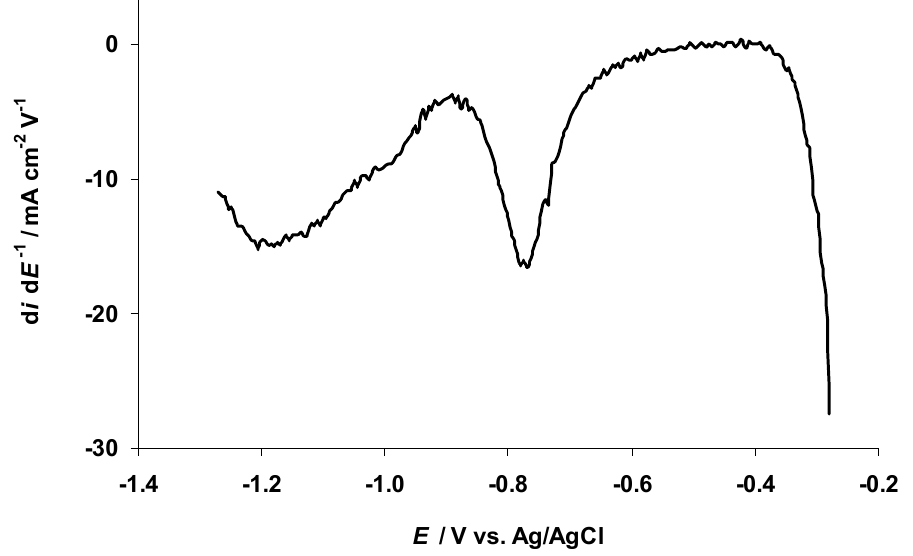
Figure 7. Differentiated potential linear sweep curve (d i d E − 1 ) recorded for negatively polarized C fiber microelectrode soaked in the 5 wt % EMImBr solution in EMImBF 4 . The second sweep was shown measured at the normal pressure in the Ar-filled glove box conditions starting at E = − 0.27 V and ending at E = − 1.27 V, with a potential scan rate of 1.0 mV s − 1 .